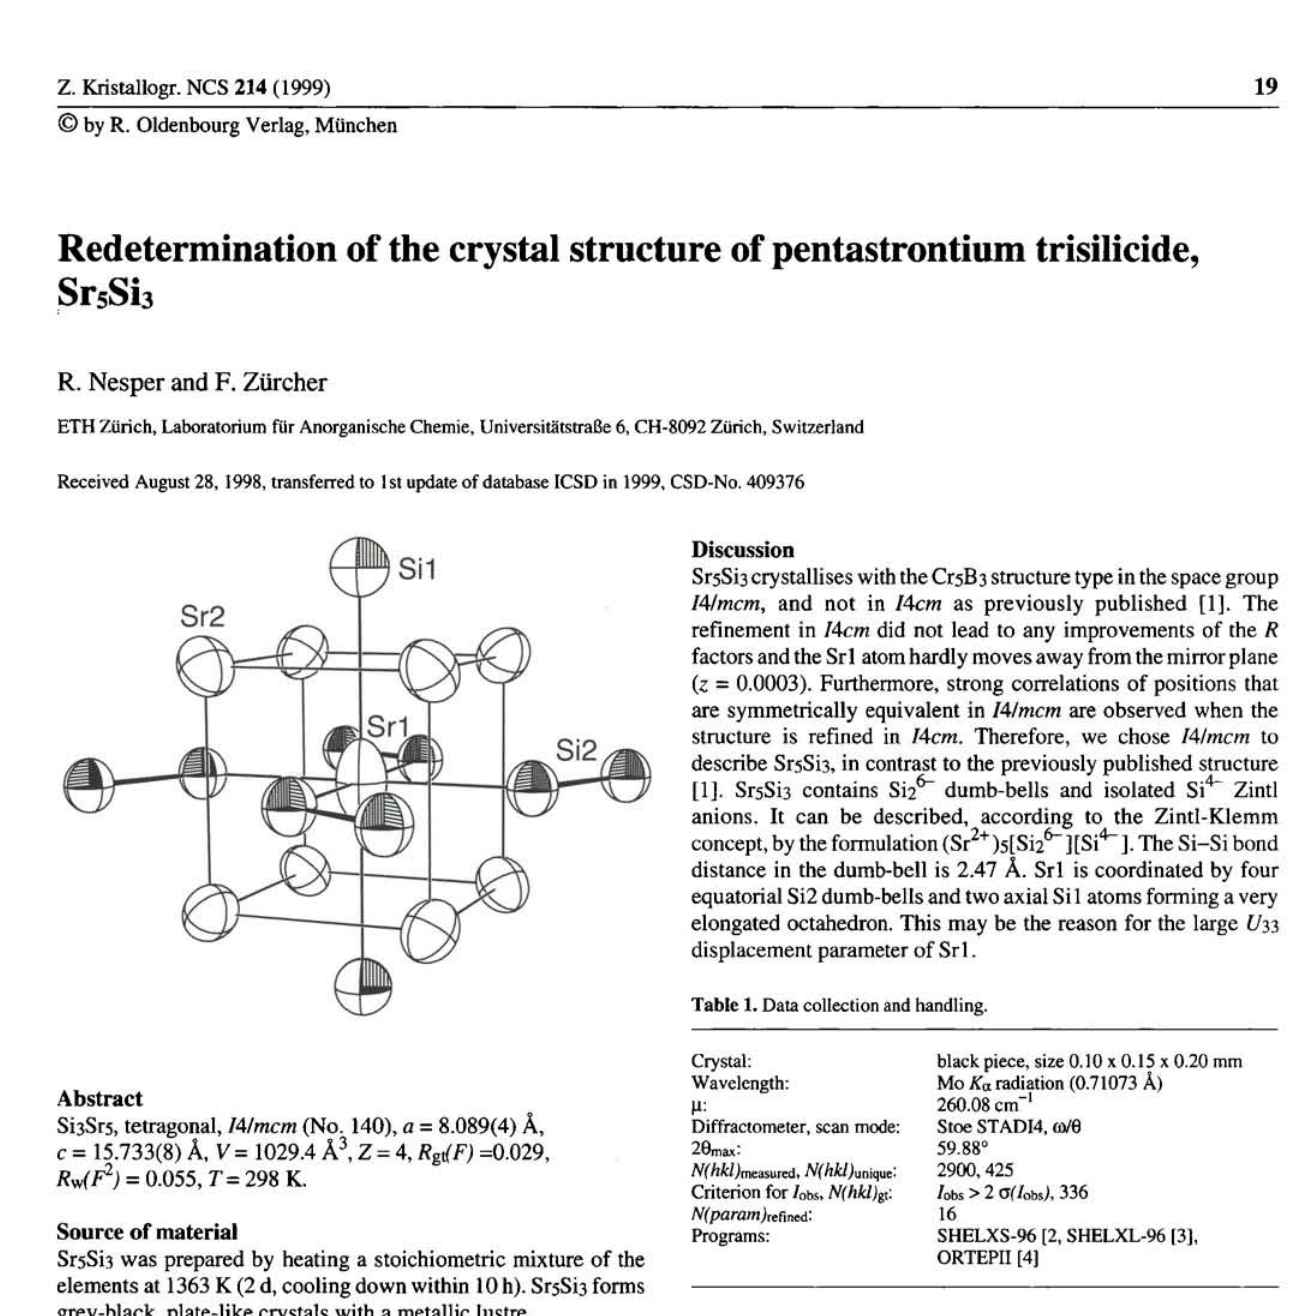
Table 2. Atomic coordinates and displacement parameters (in Â 2 ).